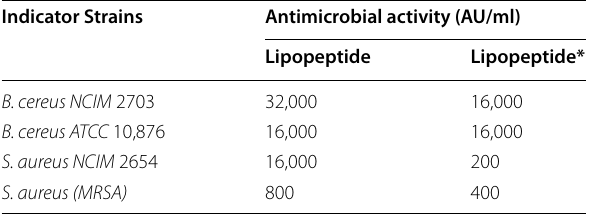
Table 3 Antimicrobial activity of purified surfactin against selected Gram-positive including antibiotic-resistant food born pathogen Indicator